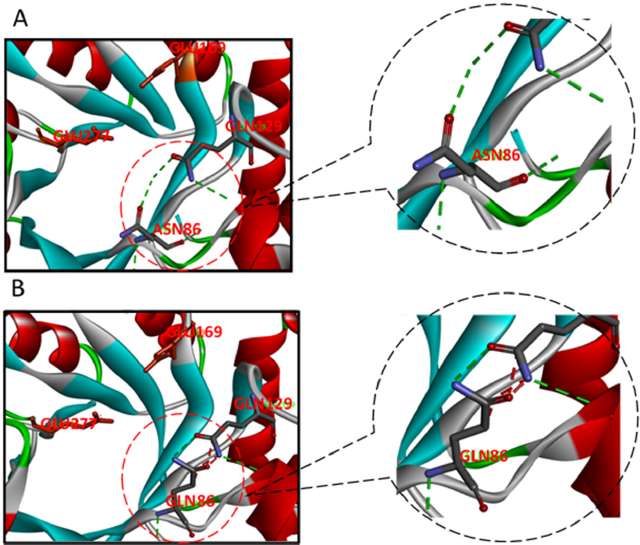
Figure 7. Modeling locations of the binding sites and catalytic sites of GH10-N86 ( A ) and GH10-N86Q ( B ). The green lines stands for favorable bump interaction, and the red lines stands for unfavorable bump interaction.